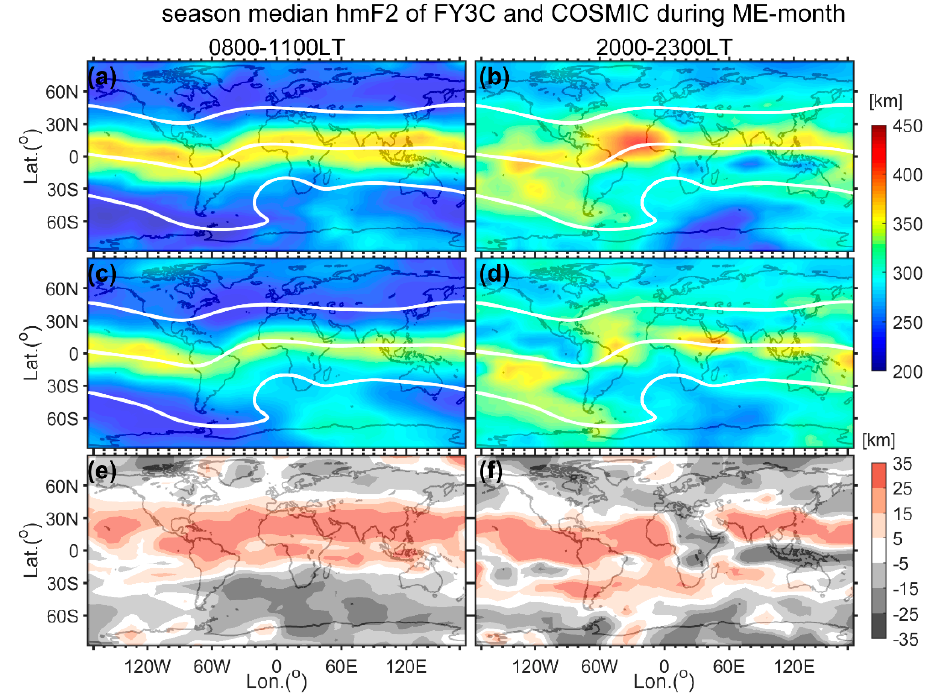
Figure 10. Ionospheric climatological characteristics of season median hmF2 observed by FY3C/GNOS and COSMIC and their differences at 0800–1100LT and 2000–2300LT during ME-month (2016.035-2016.125). ( a , b ) The climatological characteristics of season median hmF2 observed by FY3C/GNOS at 0800–1100LT and 2000–2300LT, respectively. ( c , d ) The climatological characteristics of season median hmF2 probed by COSMIC at 0800–1100LT and 2000–2300LT, respectively. The dip contours in (a–d) are represented by white curves, which are 60 ° dip, 0 ° dip, –60 ° dip from top to bottom, respectively. ( e , f ) The absolute errors of season median hmF2 between FY3C/GNOS and COSMIC at 0800–1100LT and 2000–2300LT, respectively. Obtaining of the hmF2 absolute error can be seen in Section 2.2.